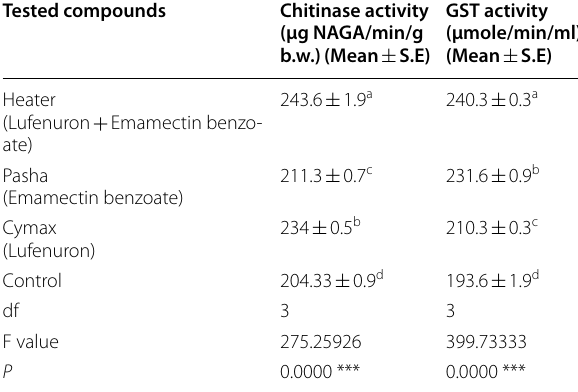
Table 7 Effect of the tested compounds on Chitinase activity, and GST activity 4th instar larvae of S. littoralis after treatment with LC 50